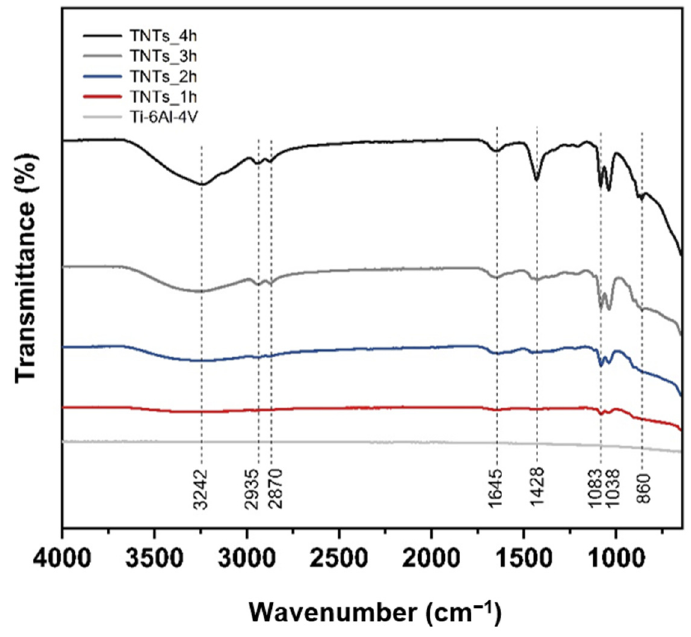
Figure 5. The ATR-FTIR spectra of the 3D-printed Ti-6Al-4V and the synthesized TNTs_1h, TNTs_2h, TNTs_3h and TNTs_4h at a different anodization time and scanning range of 4000–600 cm − 1 , containing various functional groups, which signifies the chemical properties of each specimen.